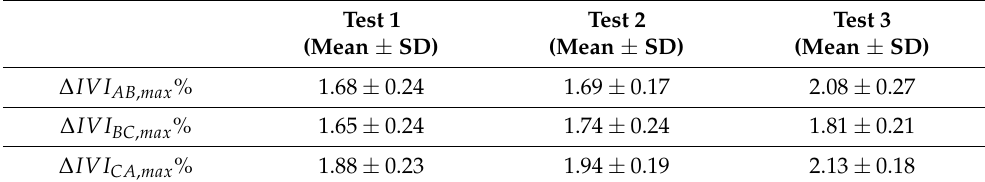
Figure 8. Atrial and aortic pressures and IVI signal recorded inside the porcine heart in the three pairs of electrodes during Test 3 (cycle rate 50 bpm, stroke volume 80 mL): AB ( left ), BC ( center ) and CA ( right ). O = start of valve opening identified with the low peak of the aortic pressure. For each working condition, the maximum percent variation in the impedance module ( ∆ IVI max %), evaluated for each pair of electrodes, was then calculated following Equation (1) as shown in Table 1. Table 1. Maximum percent variations in the impedance module, reported as ∆ IVI max % ± SD calcu- lated over 16 cardiac cycles, for each pair of electrodes (AB, BC and CA) in the three testing conditions (Test 1, Test 2, Test 3).